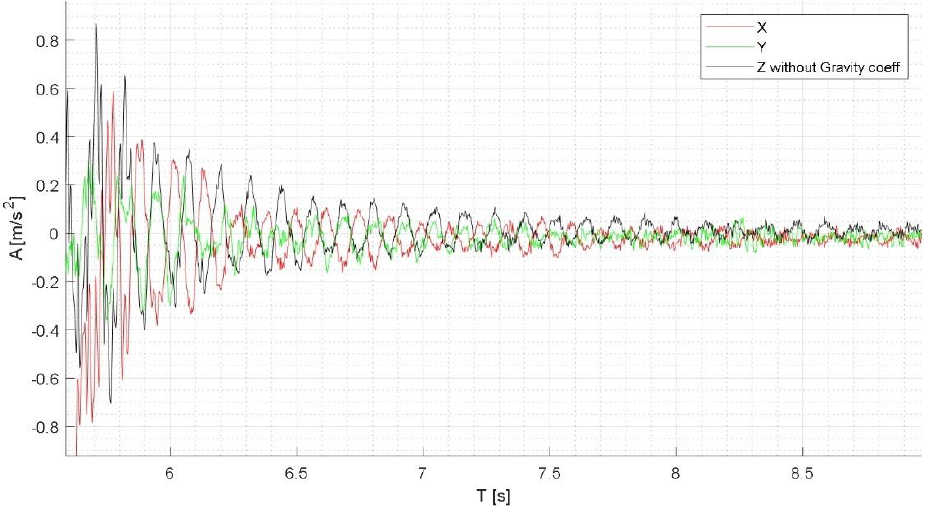
Figure 15. Acceleration graph area after robot stop for V4000, ACC100 parameters for the X, Y, and Z axes.